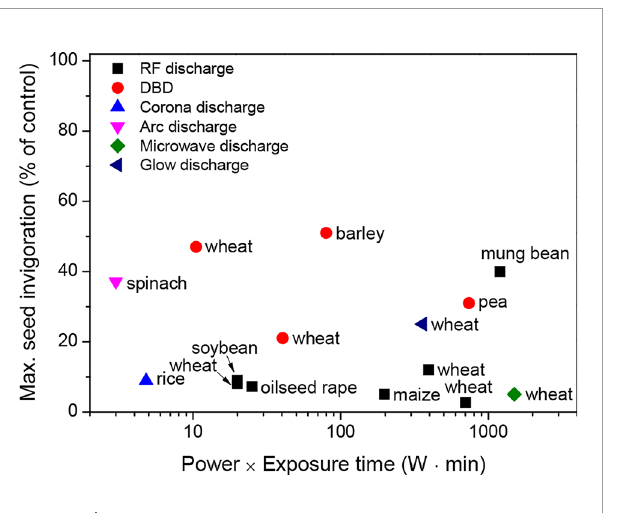
FIGURE 2 | Maximum seed invigoration (% of control) as a function of the power (W) and exposure time (min) of the plasma treatments for a wide range of crops, which were described in the literature presented in Table 1